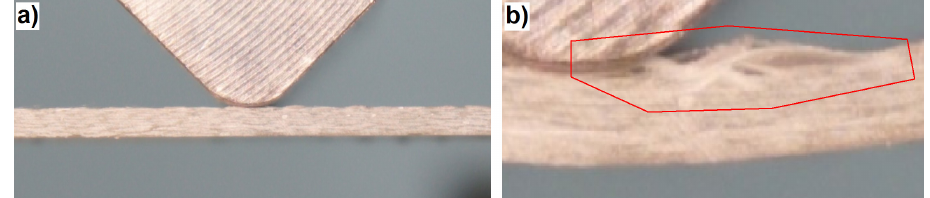
Figure 5. Photograph showing the main failure in the classic laminate: ( a ) Beginning of the bending tests and ( b ) 35 s of the test, right after the occurrence of the main failure.